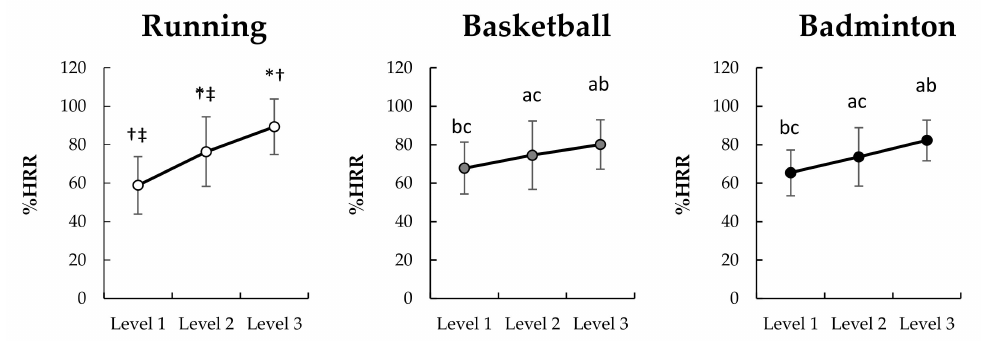
Figure 3. Change of %HRR among three exercise intensity levels under different sports ( n = 14). Bonferroni post hoc test: significantly different than a Level 1, b Level 2, and c Level 3 ( p < 0.05);